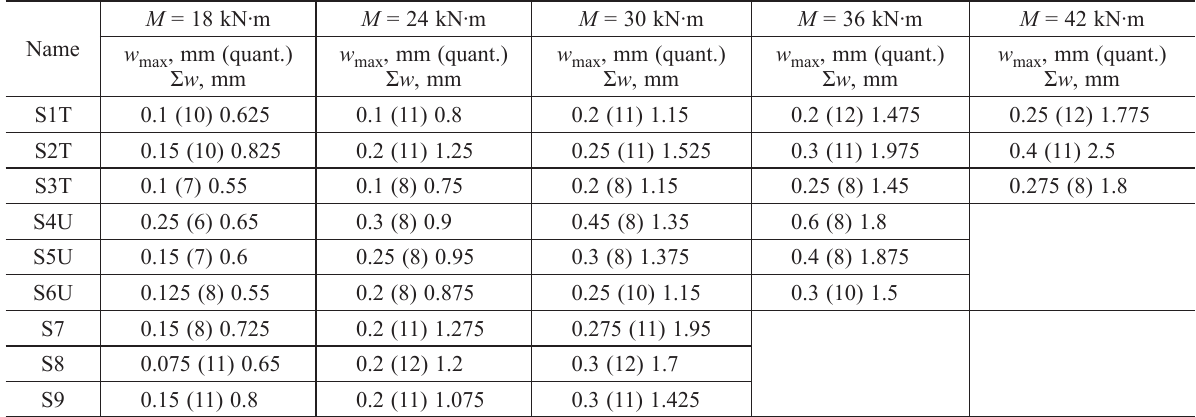
Table 12. Parameters of the cracks from the pure bending region: maximal width, quantity, sum of the cracks